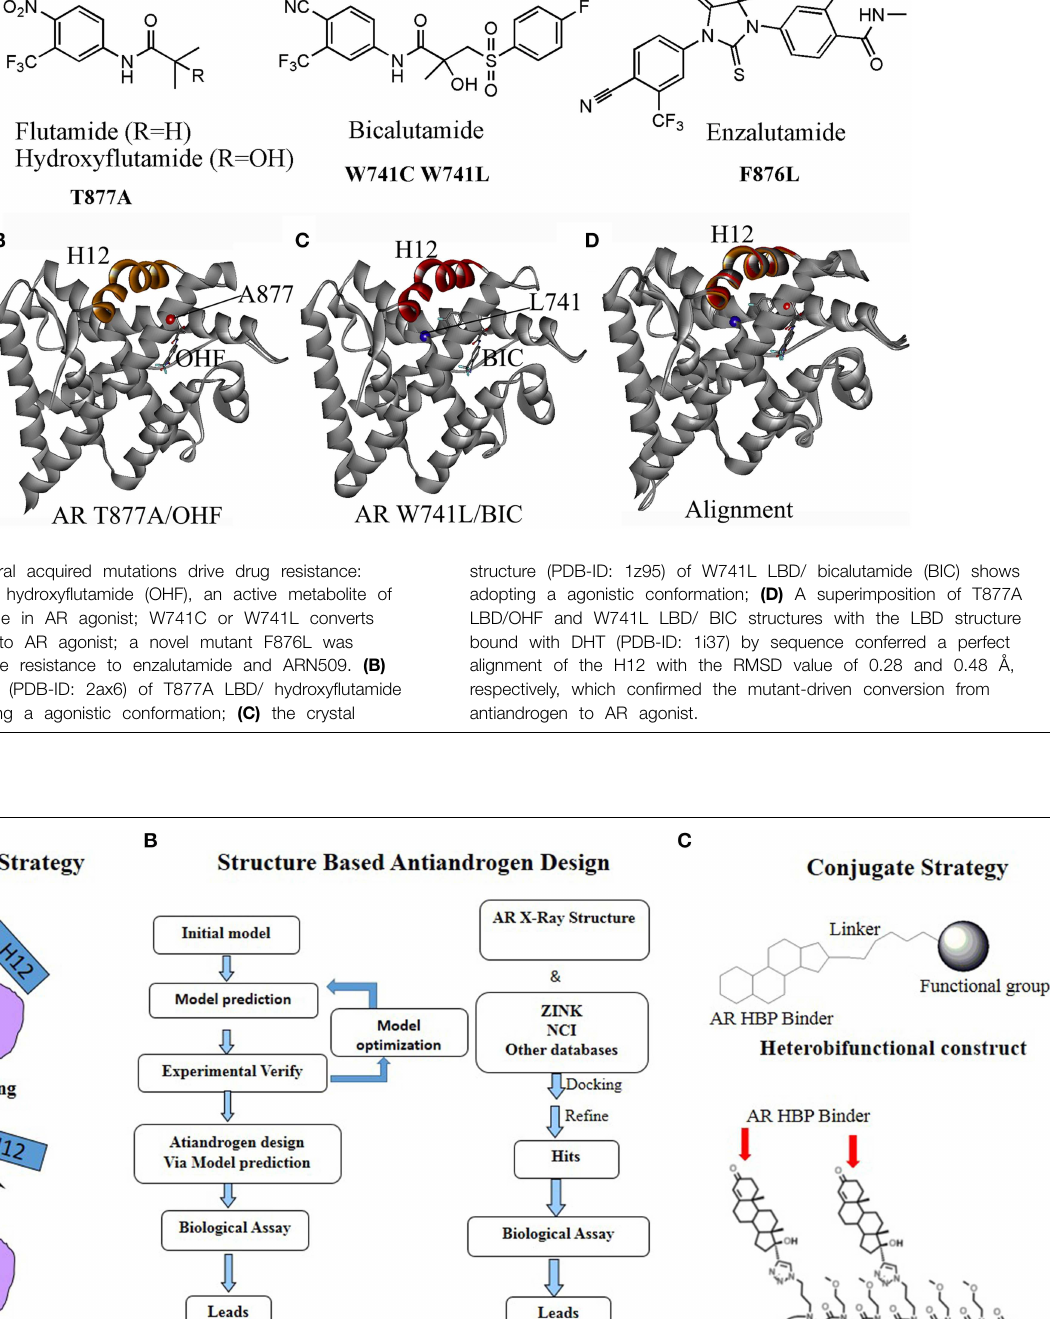
FIGURE 3 | Rational antiandrogen design strategy to combat the mutation driven drug resistance: (A) Bulky group strategy; (B) Structure based antiandrogen design; (C) Conjugate strategy.